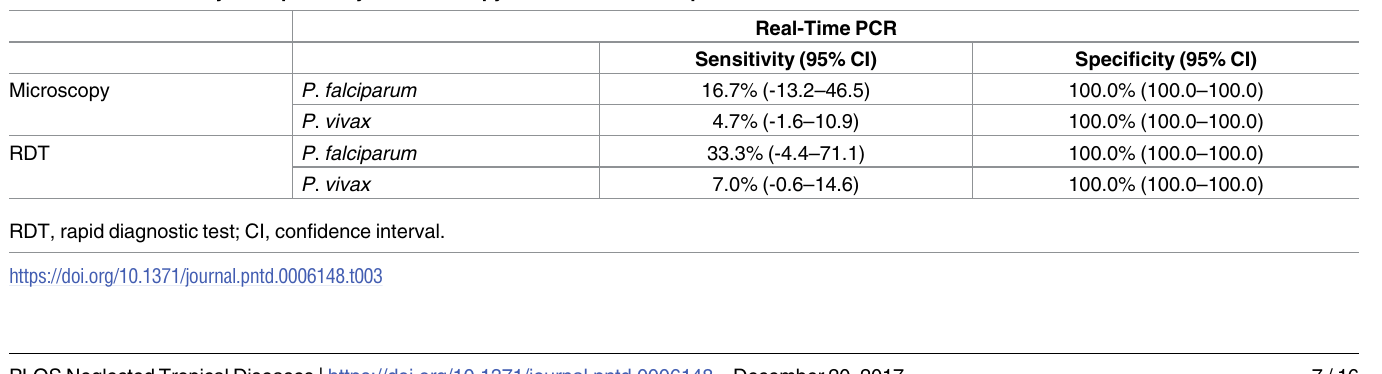
Table 3. The sensitivity and specificity of microscopy and the RDT in comparison to real-time